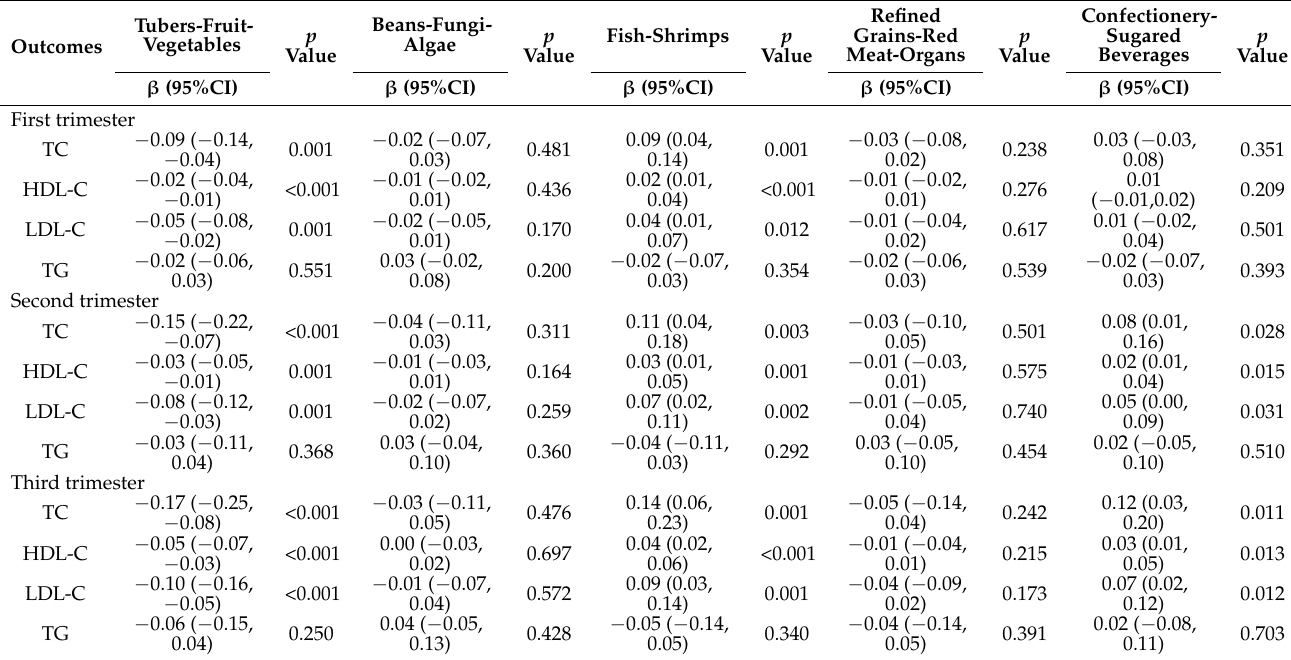
Table 4. The associations between dietary pattern scores and blood lipid levels during pregnancy * ,‡ .